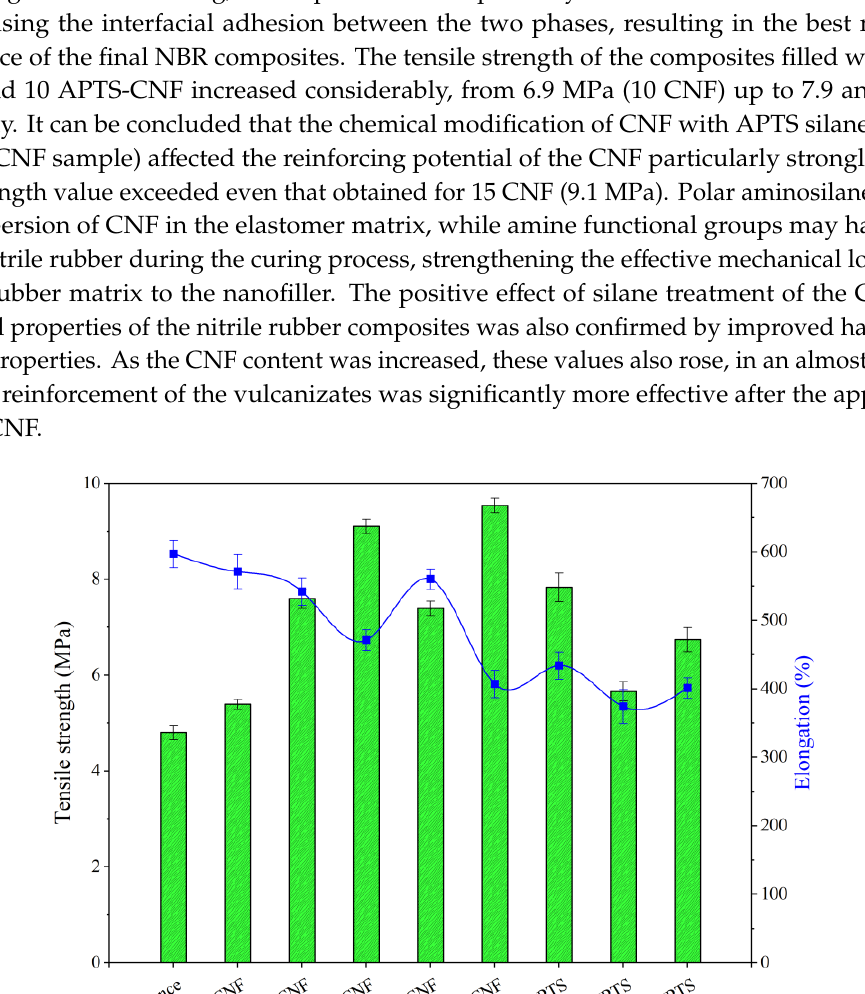
Figure 11. Hardness parameters obtained for NBR composites with modified carbon nanofibers.